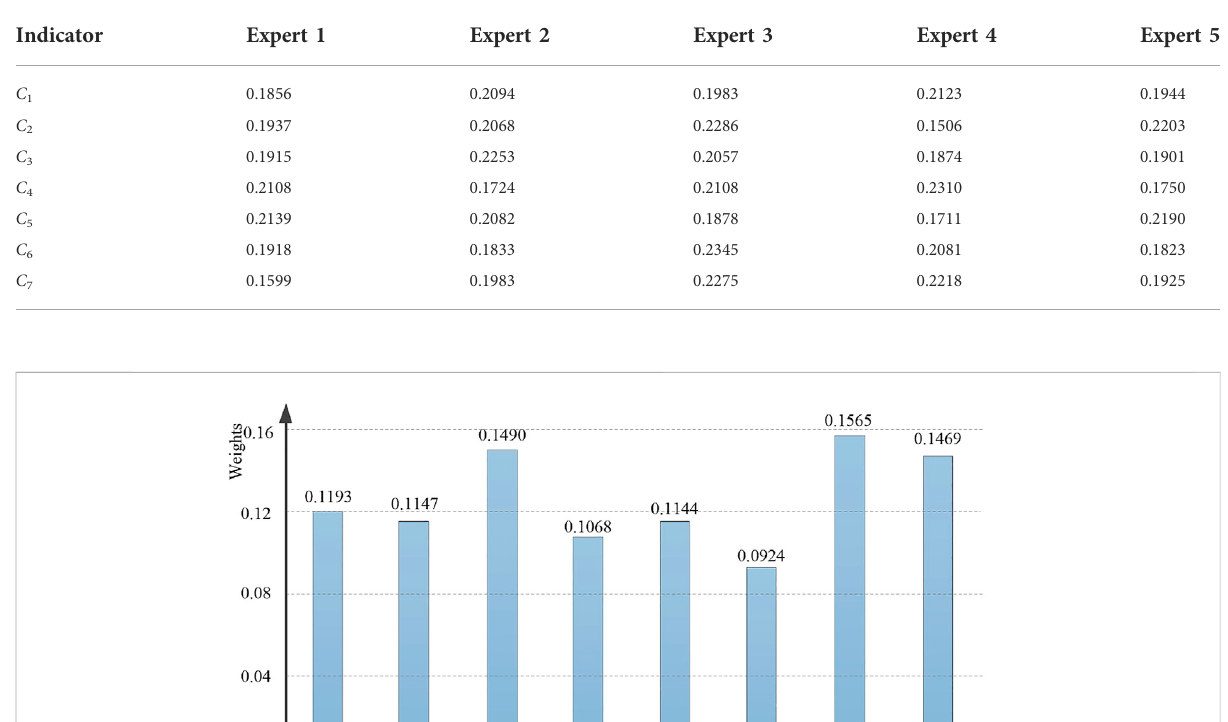
TABLE 3 Weights of fi ve experts in evaluating two-level indicators.